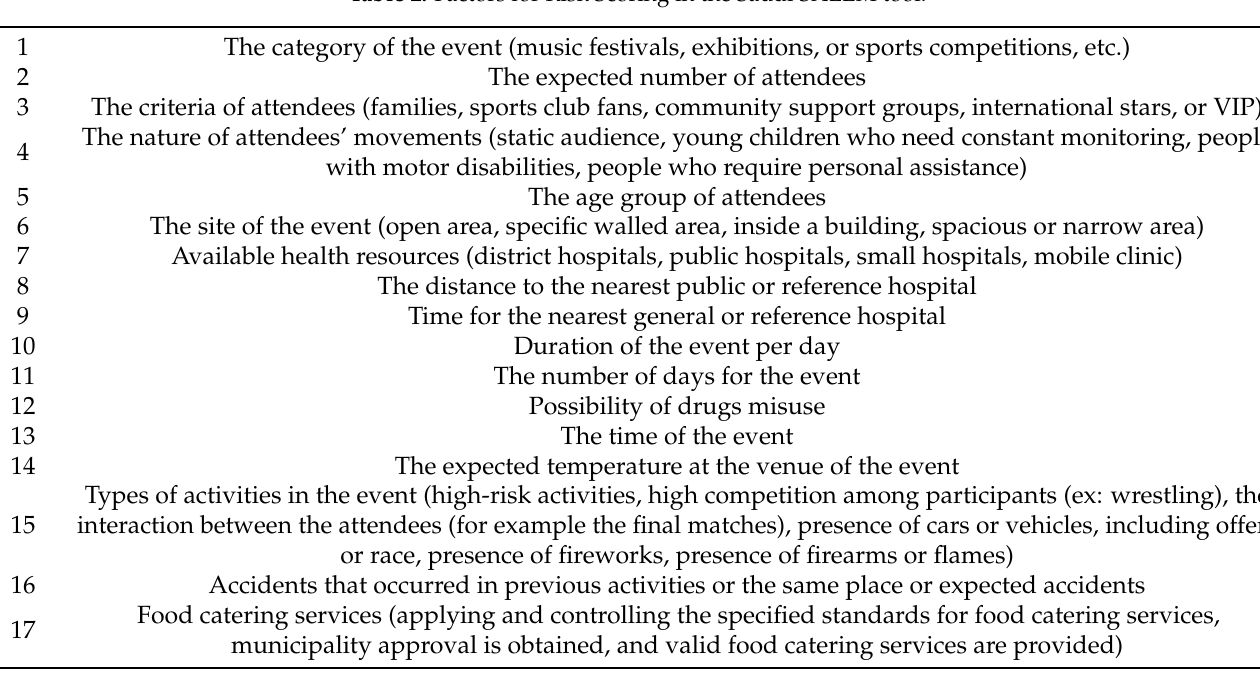
Table 2. Factors for Risk Scoring in the Saudi SALEM tool.